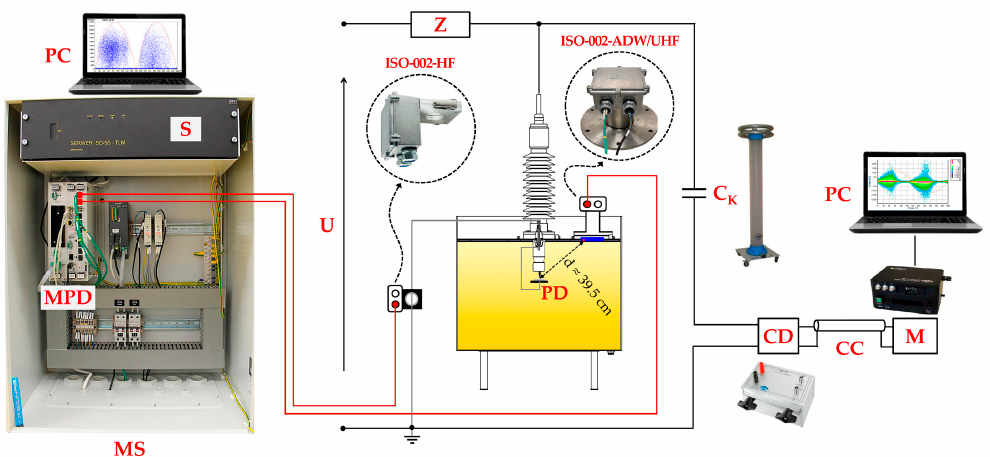
Figure 23. Schematic diagram of the measurement setup in which the monitoring system software module for performing PRPD patterns was tested: MS = partial discharge monitoring system, MPD = multichannel signal concentrator, S = server, PC = computer, U = high-voltage supply, Z = short-circuit current limiting resistor, TT = oil-filled transformer tank; PD = electrode system for partial discharge generation, C = coupling capacitor, CD = coupling device (measuring impedance), CC = connecting cable, M = conventional partial discharge measuring instrument.